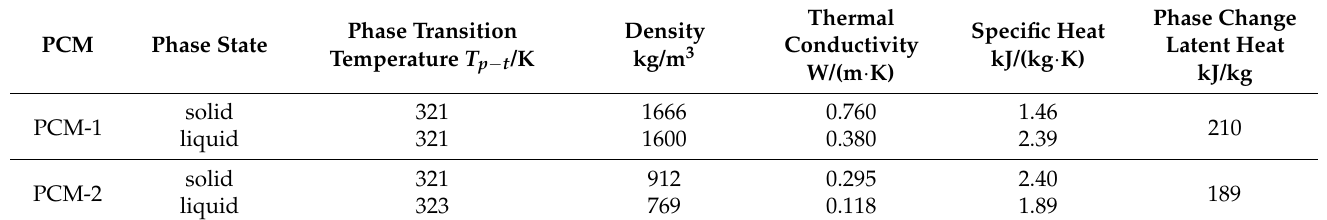
Table 2. Physical parameters of PCM-1 and PCM-2.